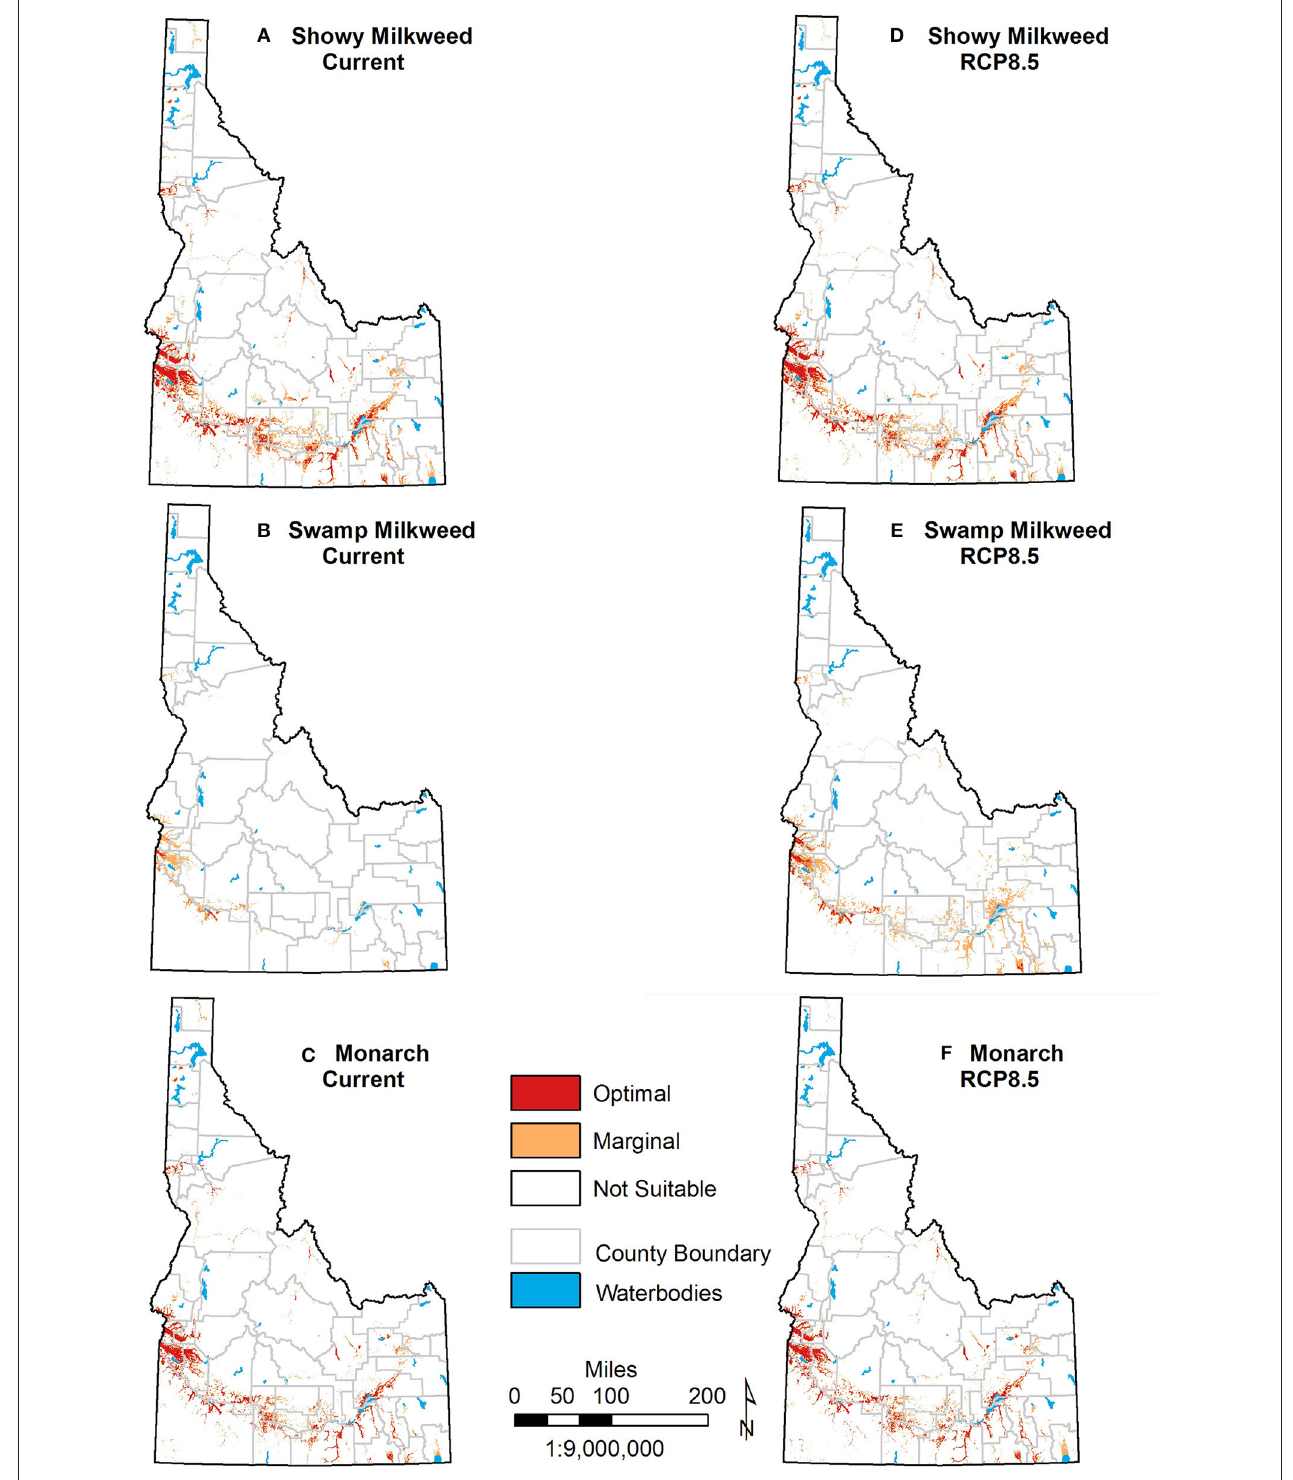
FIGURE 4 | Current and future predicted distributions of showy milkweed (A,D) , swamp milkweed (B,E) , and monarch (C,F) across Idaho. Future distributions represent 20 global climate model average ensemble projections under severe (RCP 8.5) climate change scenarios. Separation of non-suitable habitat with marginal habitat is based on the “Balance training omission, predicted area and threshold value area” threshold, and separation with optimal habitat is based on an expert-derived threshold.